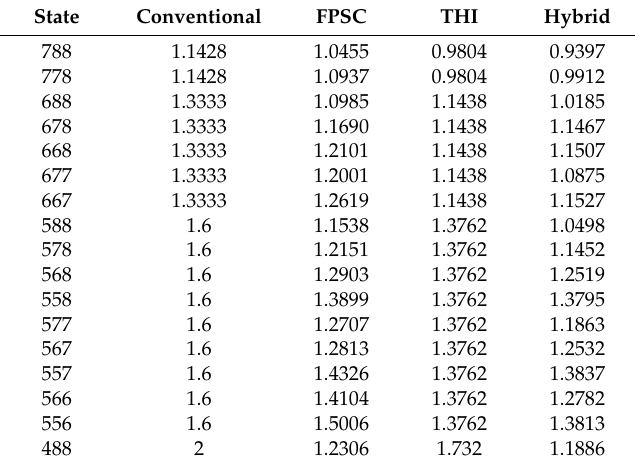
Table 3. Comparison of fault recovery factor of several fault-tolerant control